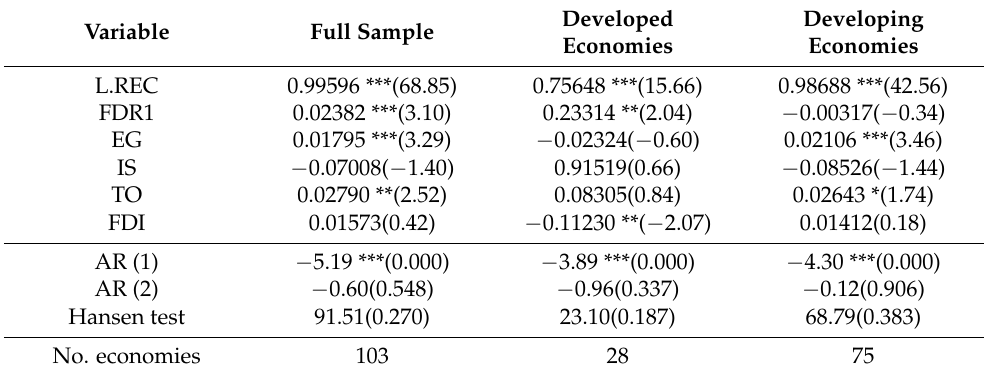
Table 11. Regression results with FDR1.